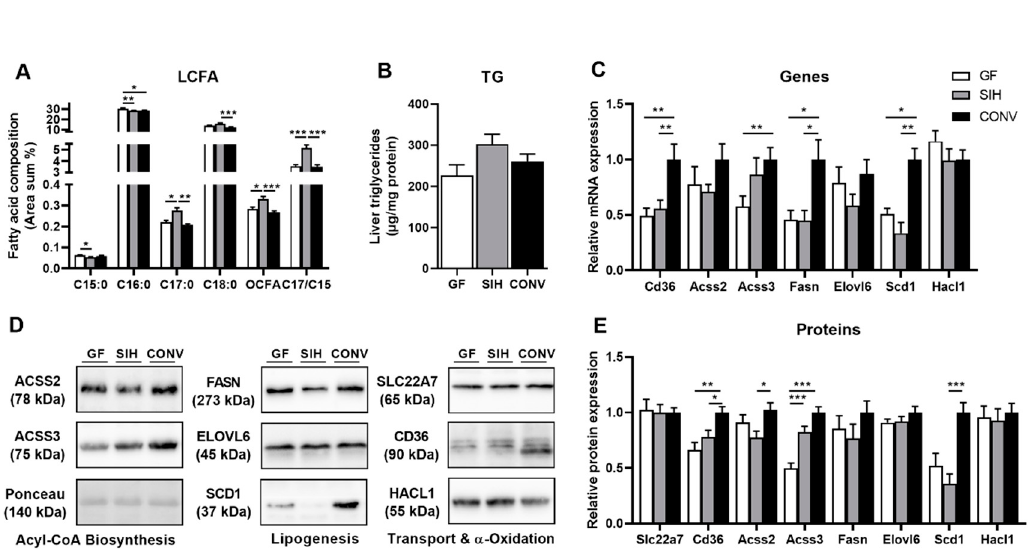
Figure 2. Germ-free mice (GF) and SIHUMI mice (SIH) on high-fat inulin diet (HFI) display reduced hepatic de novo fatty acid synthesis compared to conventional mice (CONV), while total OCFA levels are the highest in SIH mice. Sixteen-week-old male C3H/HeOuJ mice on HFI diet for 4 weeks: ( A ) long-chain fatty acid (LCFA) composition of hepatic phospholipid fraction. Results are expressed as area percentage of individual fatty acids to total area of detected fatty acids. ( B ) Hepatic triglyceride (TG) concentration. Analysis of fatty acid metabolism with both ( C ) mRNA and ( E ) protein expression. ( D ) Representative Western blots for fatty acid signaling. Data are mean + SEM ( n = 8–10) and expression data were normalized to CONV group. Actin was used as the housekeeping gene and ponceau staining as the loading control for protein. * p < 0.05; ** p < 0.01; *** p <